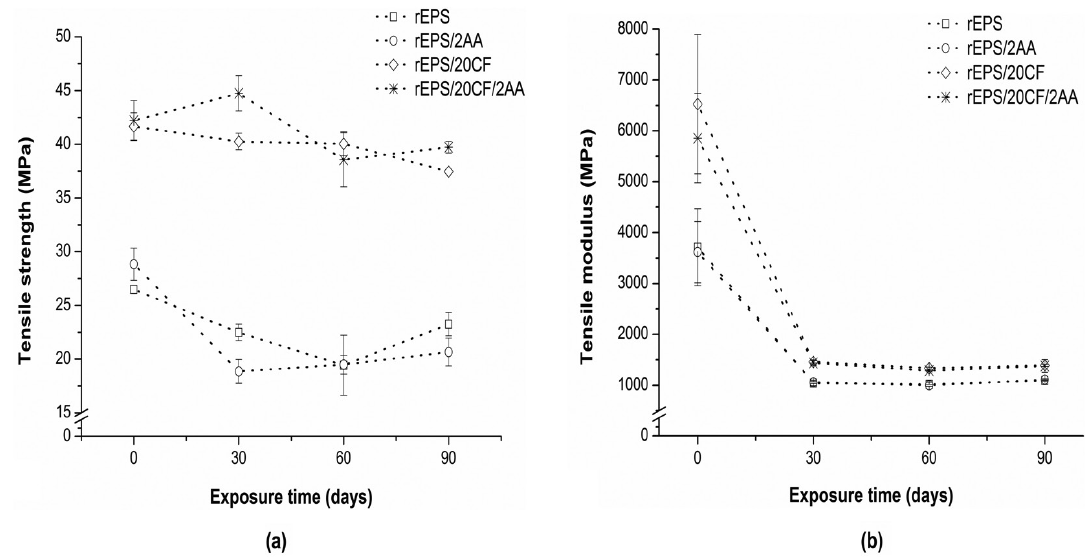
Figure 1. The measured mechanical properties of (a) tensile strength and (b) modulus of elasticity of the samples before and after exposure in the simulated